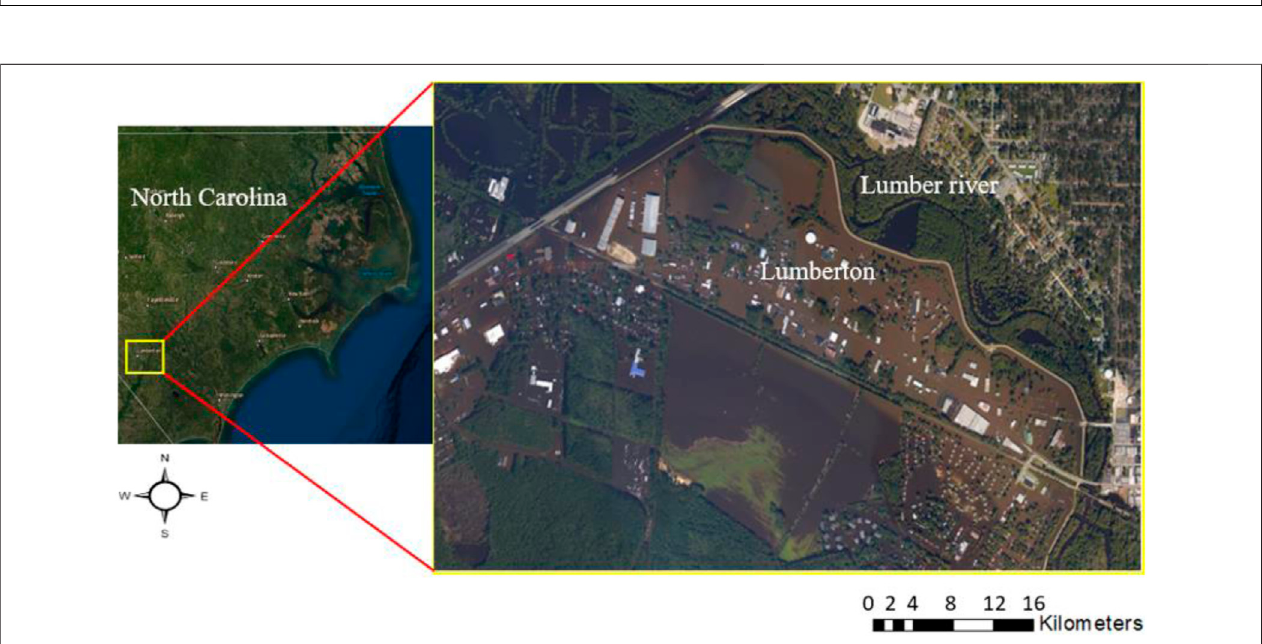
FIGURE 4 | The study area used to train the CNN network — Lumberton, NC, and during-event aircraft imagery taken in October 2016.